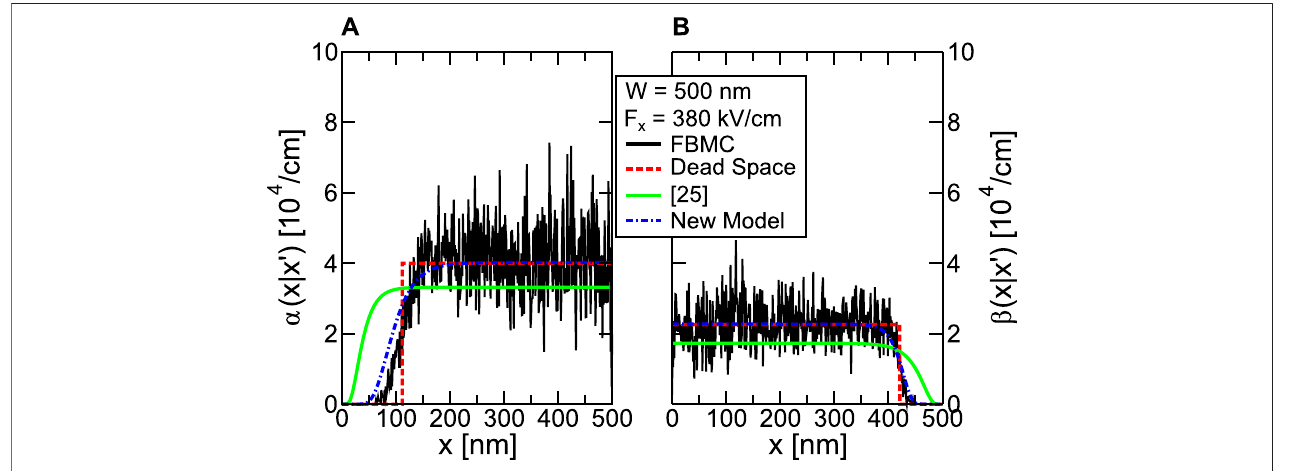
FIGURE 7 | Comparison between the α ( x | x ′ ) and β ( x | x ′ ) pro fi les extracted from FBMC simulations using the methodology presented in [34] and different NLHD models (see text). The considered structure is a GaAs region of 500 nm width under a uniform electric fi eld F x = 380 kV/cm.